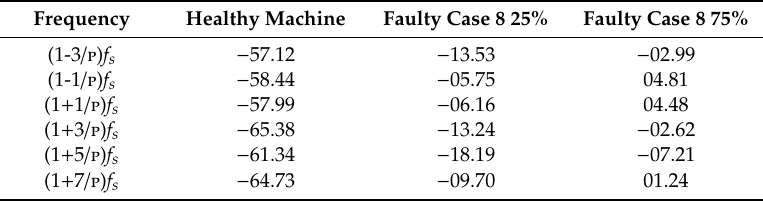
Table 8. Current harmonic components comparison due to case 8 (in dB).